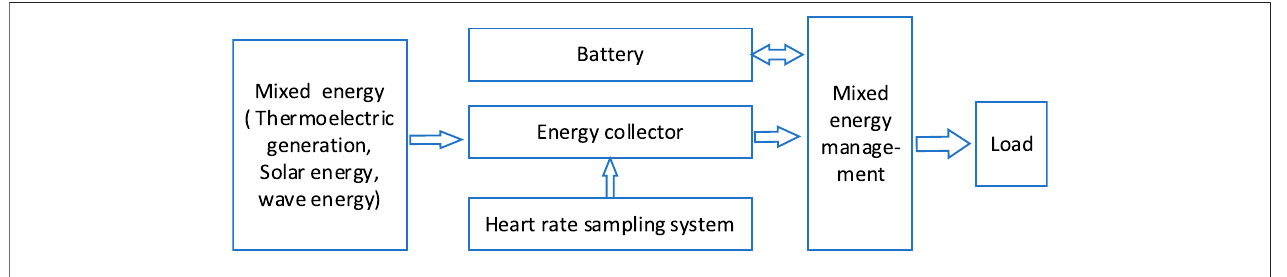
FIGURE 3 | Block diagram of hybrid energy acquisition and management of the